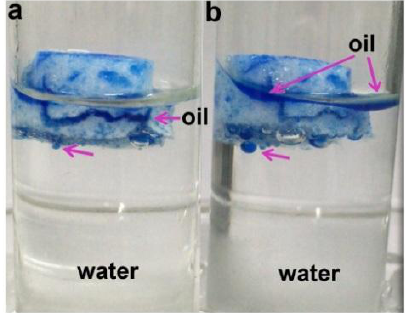
Figure 5. Photos of PNIPAM/BNNS-NH 2 hydrogels were put into the cold water for 5 min ( a ) and for 10 min ( b ).